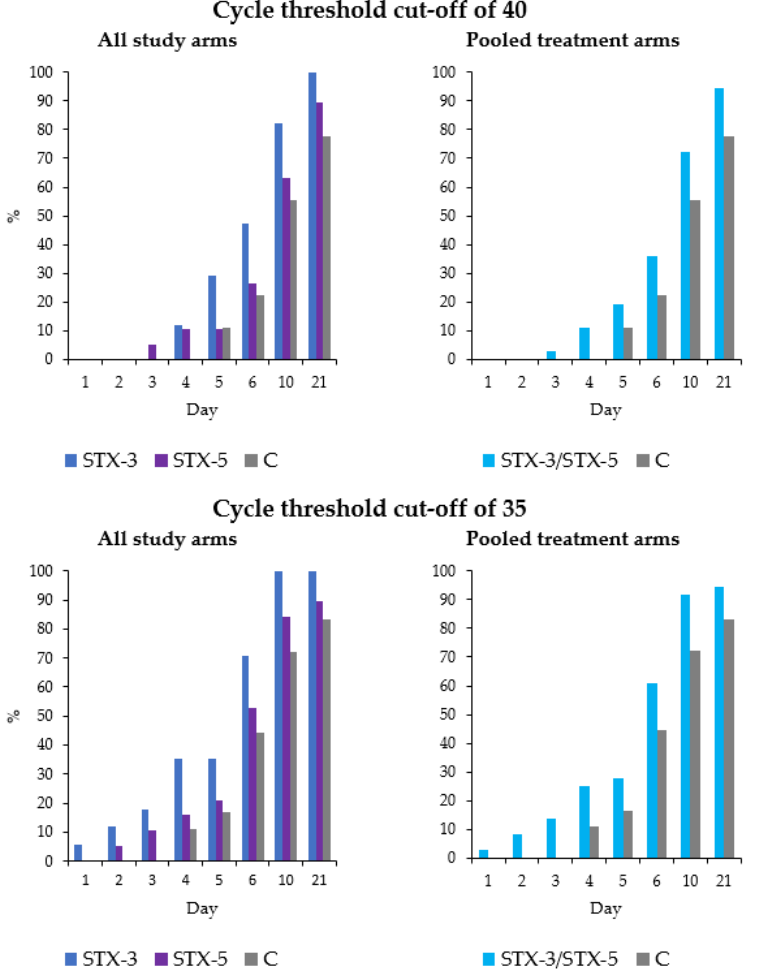
Figure 4. Proportion of negativized subjects in the intention-to-treat (ITT) analysis, by negativiza- definition, study arm and day of tion definition, study arm and day of follow-up.